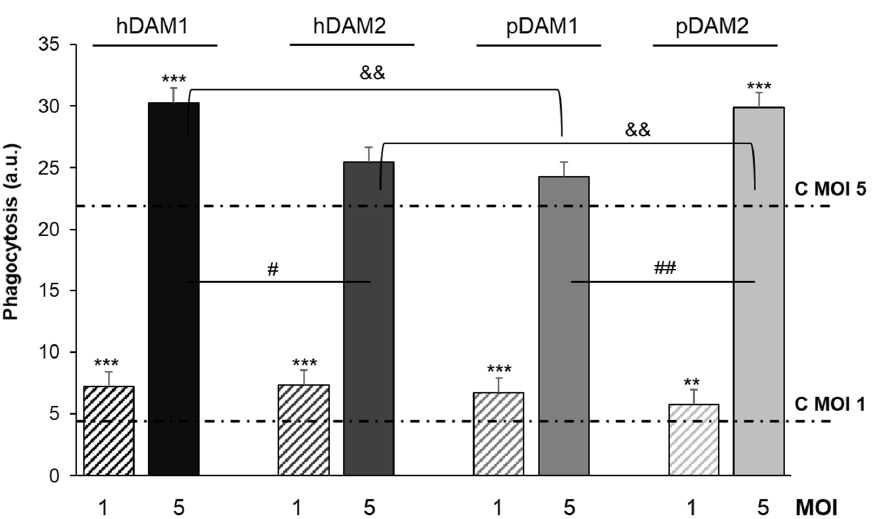
Figure 6. RFP- Candida albicans phagocytosis by RAW-264.7 macrophages cultured on human (h) and porcine (p) DAMs obtained by either enzymatic method (hDAM1 and pDAM1) or treatment with organic solvents (hDAM2 and pDAM2), after 45 min of treatment with the fungus (MOI 1 and MOI 5) and flow cytometric analysis. Statistical significance: *** p < 0.005, ** p < 0.01 (comparison of the results obtained in the presence of matrix at MOI 1 and MOI 5 with their respective controls without matrix, lines C MOI 1 and C MOI 5). # p < 0.05, ## p < 0.01 (hDAM1 vs. hDAM2, pDAM1 vs. pDAM2, at MOI 5). && p < 0.01 (hDAM1 vs. pDAM1 and hDAM2 vs. pDAM2, at MOI 5).